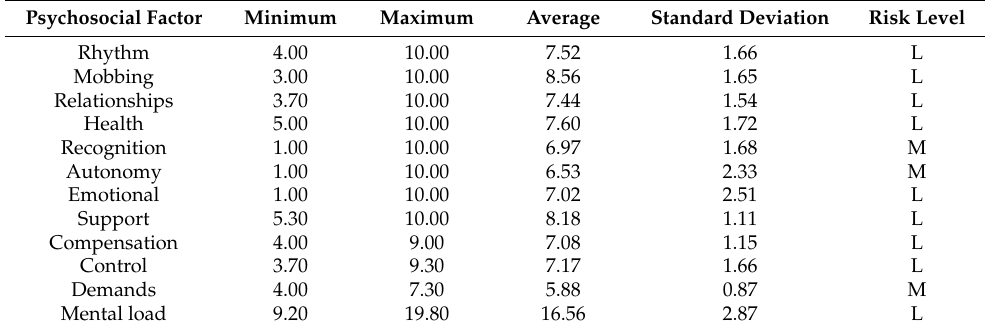
Table 3. Descriptive analysis of the scores obtained for the 12 psychosocial factors evaluated by MPF.